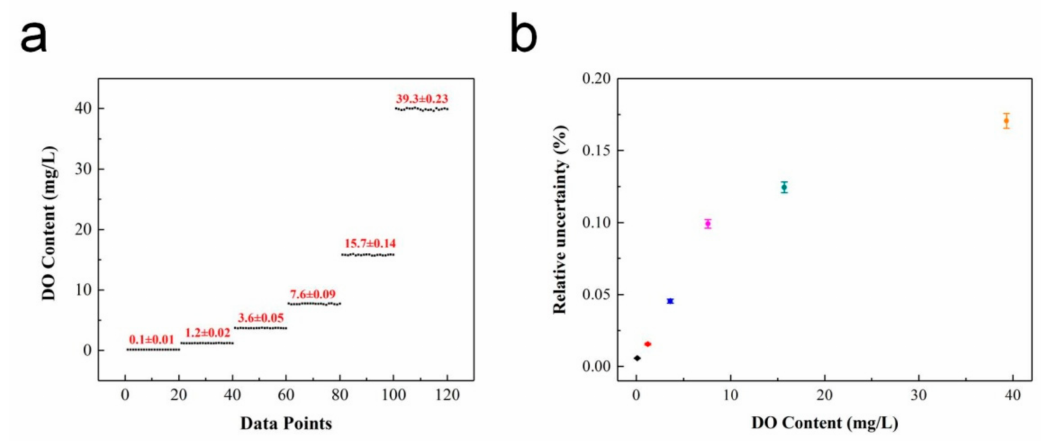
Figure 8. Performance of oxygen sensor: ( a ) Detection limit; ( b ) Relative uncertainty versus DO